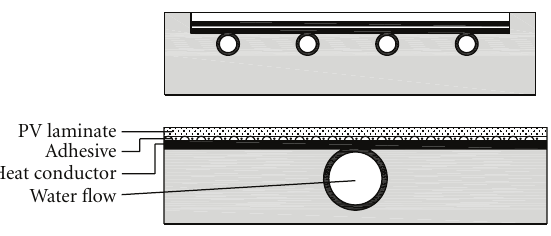
Figure 2: Sectional view of an unglazed PVT collector.